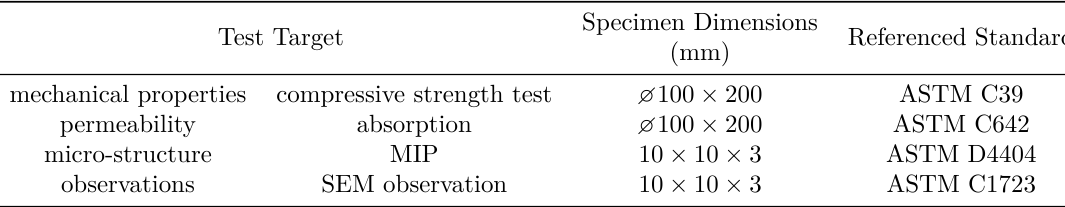
Table 3. Mix design of concrete (kg/m 3